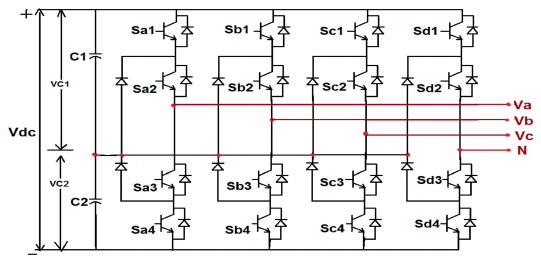
Figure 2. Circuit of a 3-phase 4-leg 3-level NPC inverter.